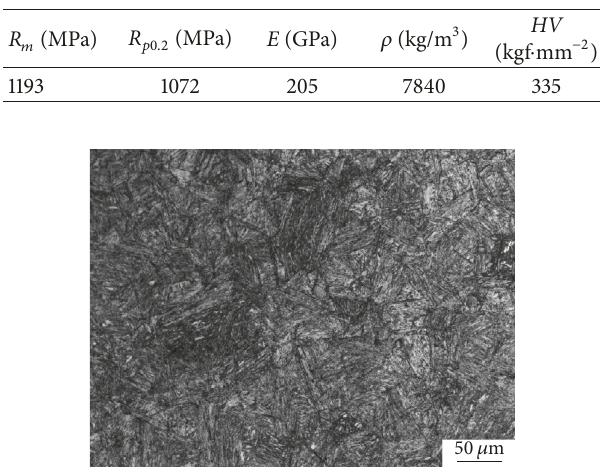
Figure 1: Microstructure of